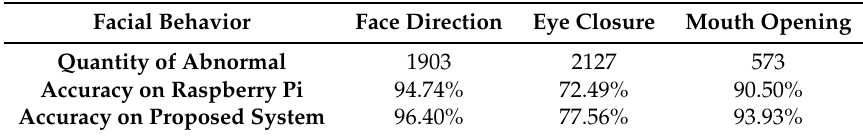
Table 5. Accuracy of the facial behavior recognition.